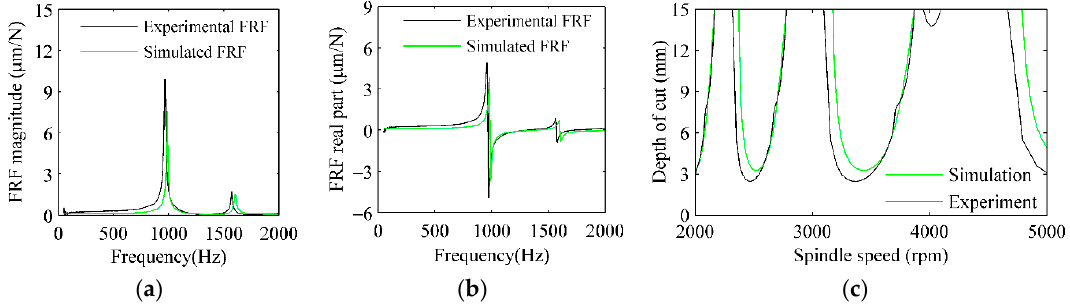
Figure 8. ( a ) Magnitude of the frequency response function (FRF) from the simulation and experiment; ( b ) real part of the FRF from the simulation and experiment; ( c ) stability lobe diagram obtained with the FRF from the simulation and experiment.